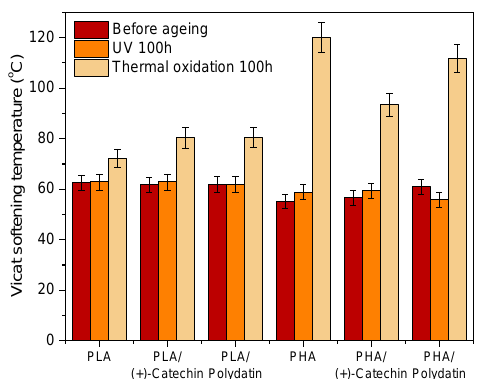
Figure 4. Vicat softening temperature of the PLA and PHA samples before and after aging.